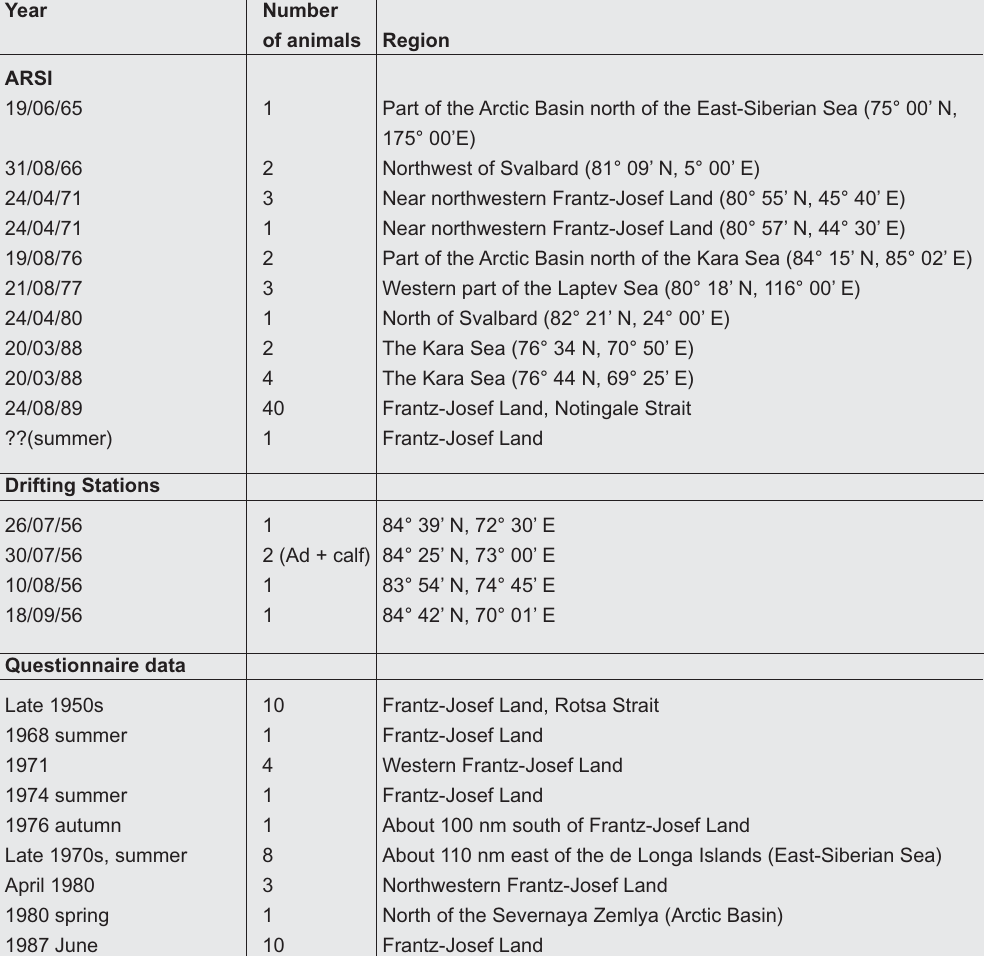
Observations of narwhals in the Russian Arctic from unpublished